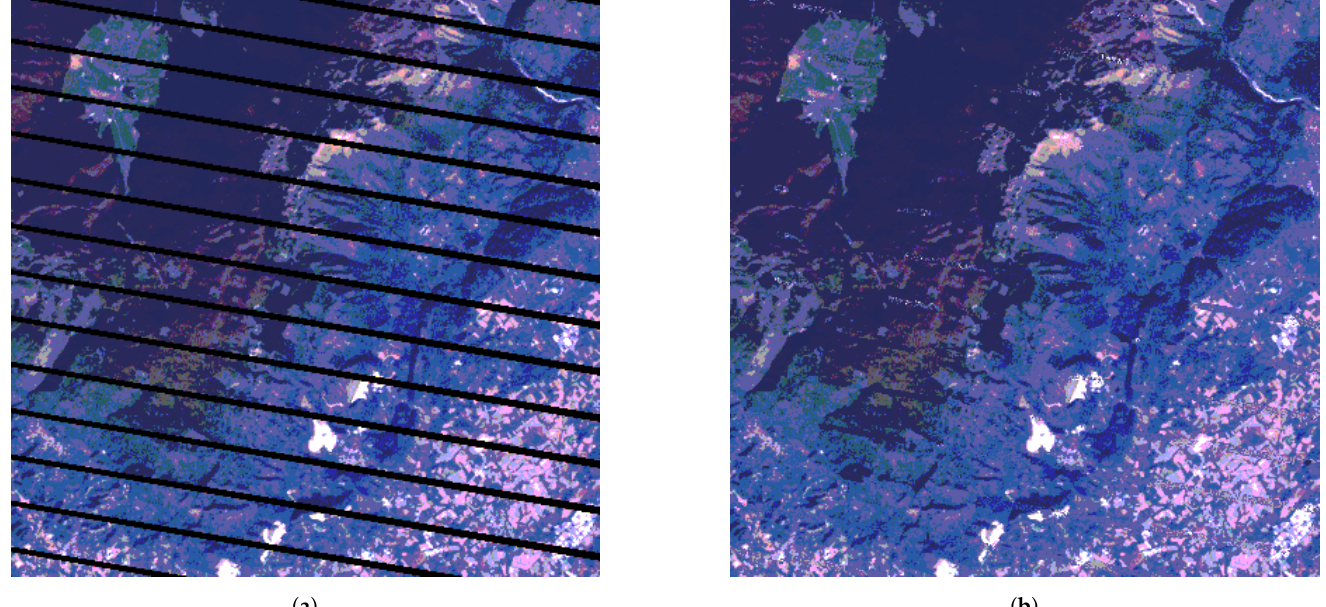
Figure 20. Target and HM reconstruction (portion of), see Figure 16. ( a ) target image; ( b ) HM